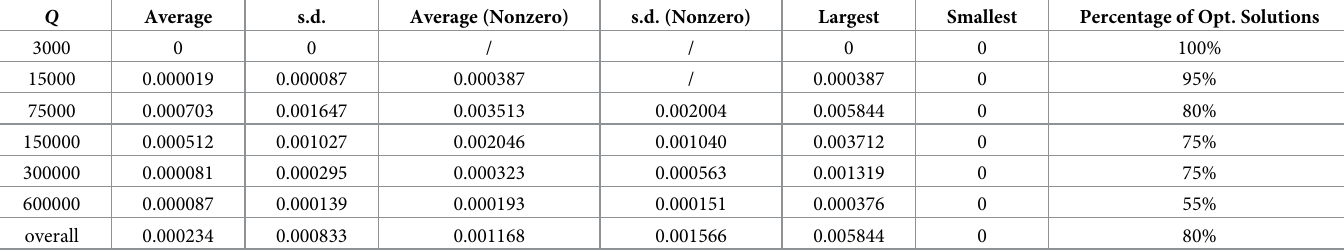
Table 15. Statistics of optimality gaps for RGDQD.